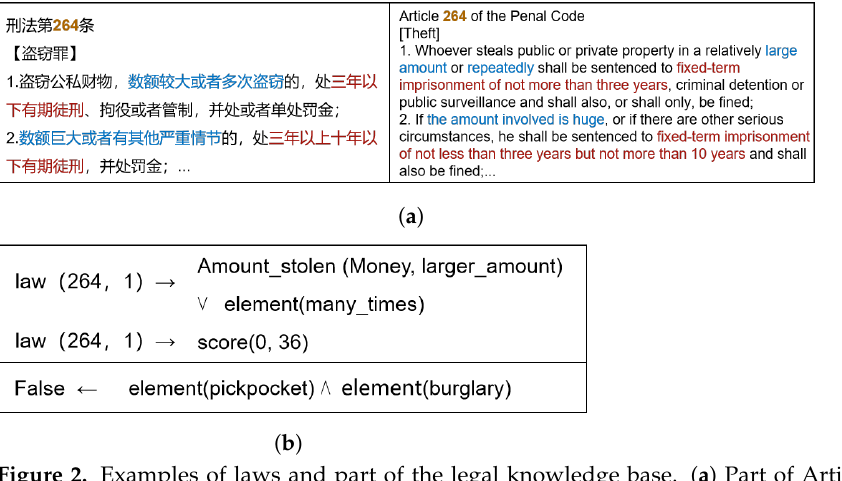
Figure 2. Examples of laws and part of the legal knowledge base. ( a ) Part of Article 264 of the Criminal Law of the People’s Republic of China. ( b ) Part of the legal knowledge